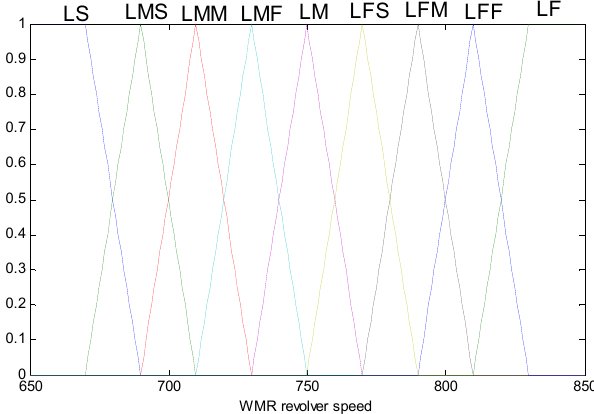
Figure 8. Membership functions of the vertical position of a moving target in an image frame.